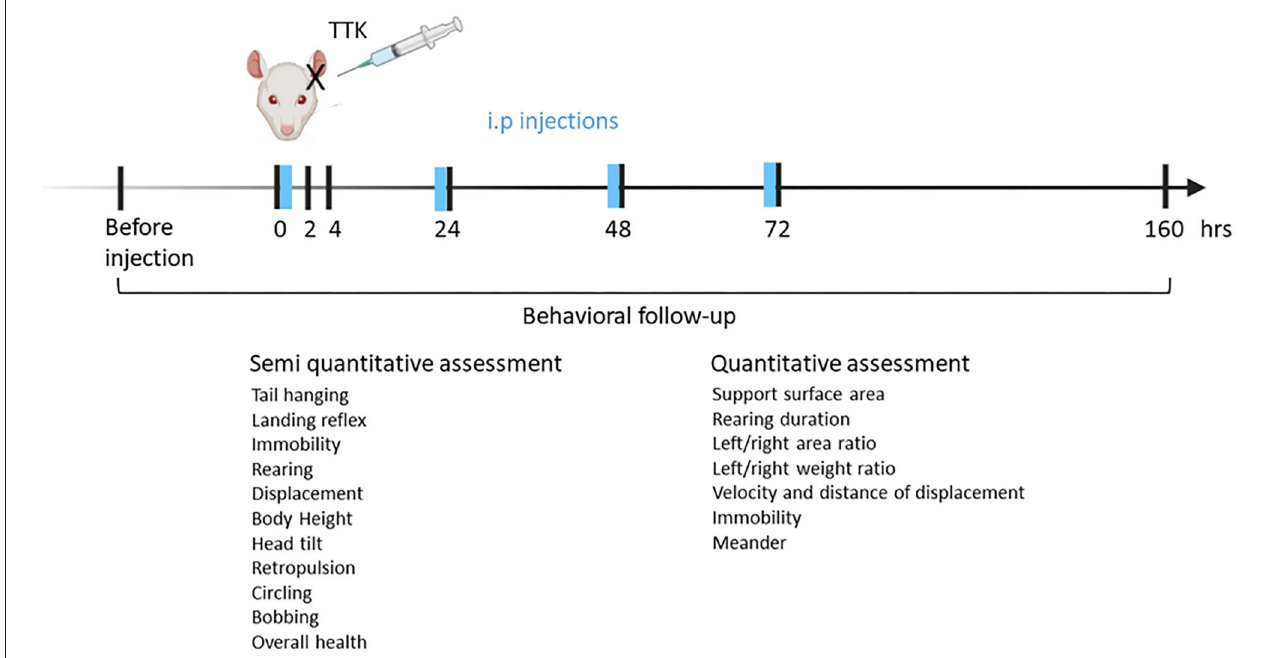
FIGURE 1 | Experimental design. Vestibular excitotoxic injury is induced by subjecting anesthetized male adult rats to unilateral transtympanic injection of kainic. The animals are left to rest for the next 30min on the ipsilateral side of the injection. T4 or T3 is immediately administered through intraperitoneal injection. To assess the effect of repeated T4 or T3 administration on the vestibular syndrome, the compound administration is repeated for the next 3 days before behavioral tests. Behavior follow-up is started before transtympanic injection for control values and continued at 2, 4, 24, 48, 72h, and 1